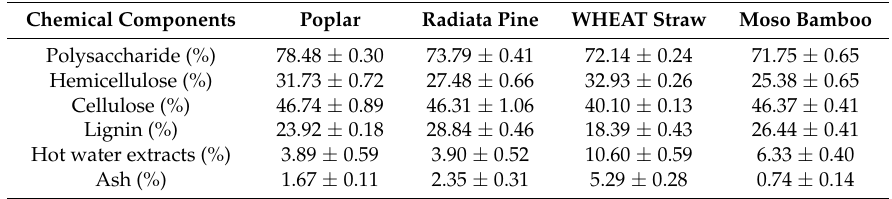
Table 1. Chemical properties of biomass particles used in bio-composites